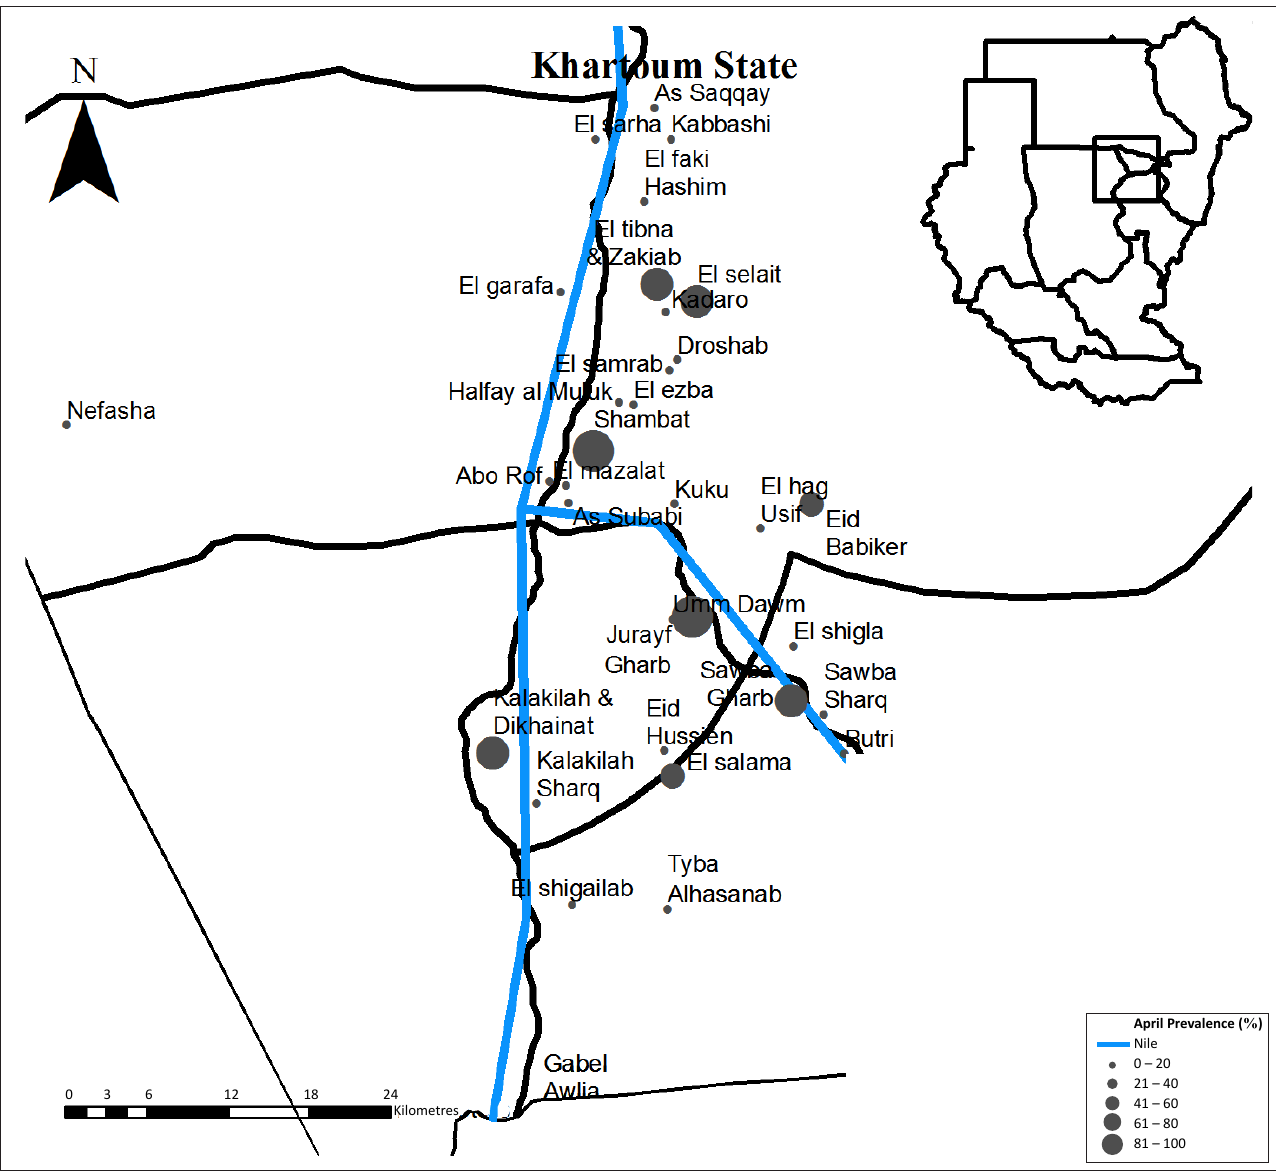
Source : Figure created from census data by using ArcGIS FIGURE 2: Spatial distribution of antimicrobial residues in farms in Khartoum State surveyed in April